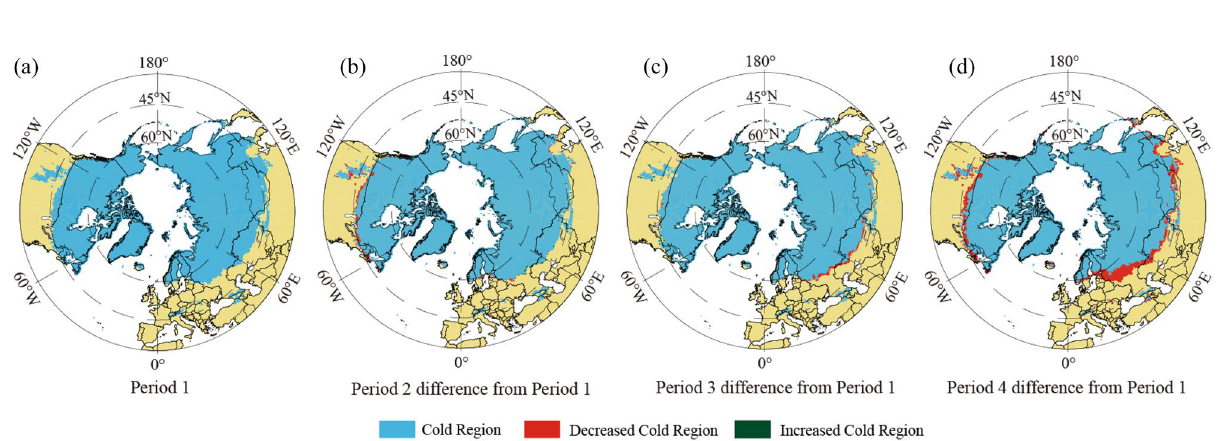
Figure 4. Spatial distribution and variation of the Mid-to-High latitude cold regions of the NH from 1901 to